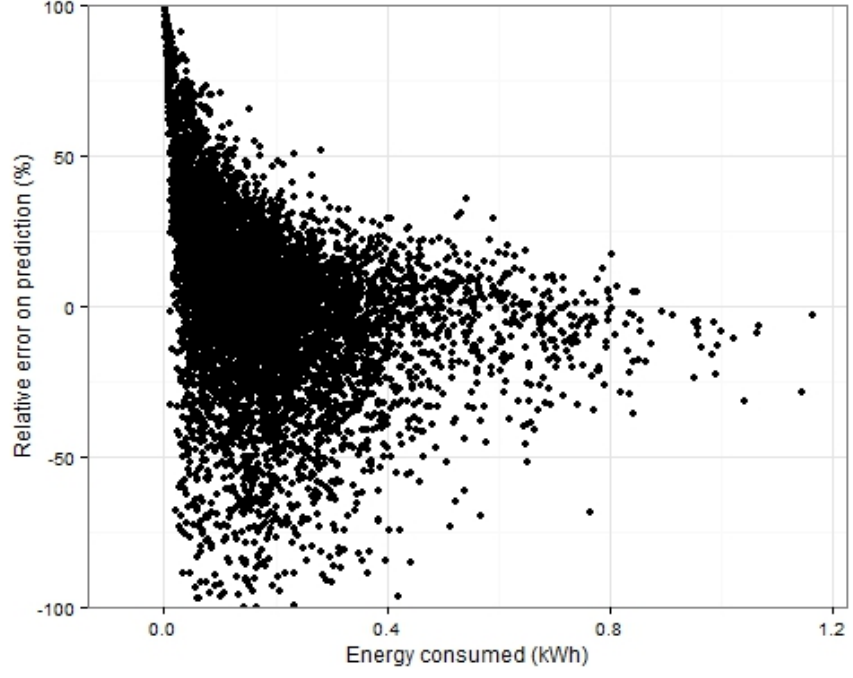
Figure 9. Relative errors on the micro-trip energy consumption predictions using the micro model.